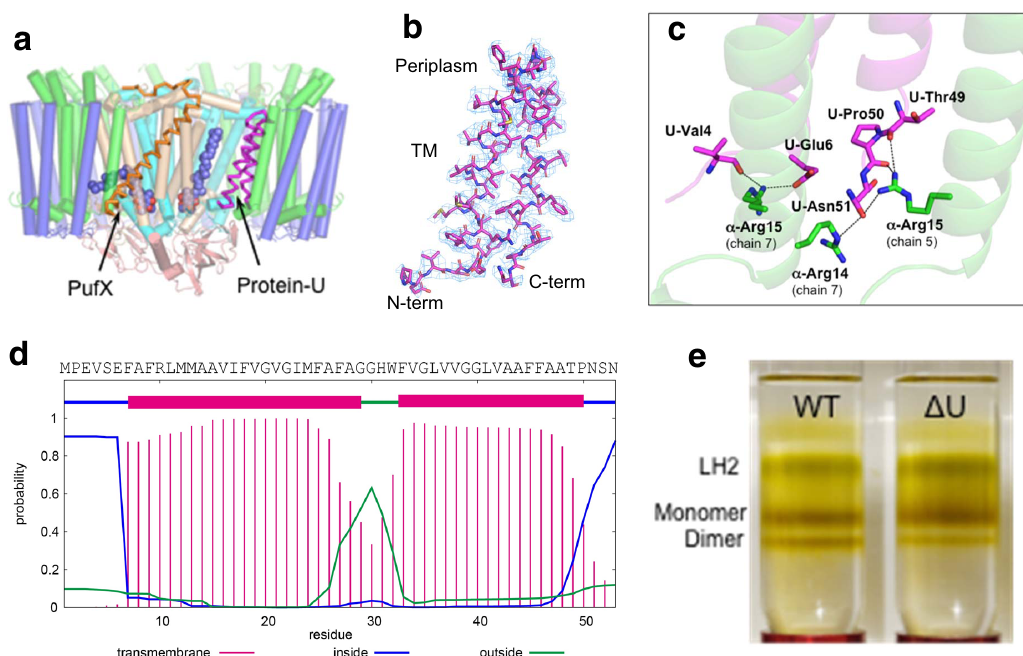
Fig. 2 Structure and property of Rba. sphaeroides protein-U. a Relative position of protein-U (magenta ribbon) in the LH1-RC. PufX is shown by the orange ribbon and the UQ-10 at Q A and Q B sites are shown by blue spheres. All other proteins are shown by cylinders with the same color scheme as in Fig. 1(a). b Structure of protein-U and its density map at a contour level of 3.0 σ . c Close contacts (<3.5 Å, dashed lines) between the protein-U terminal regions (magenta) and LH1 α -polypeptides (green). d Amino acid sequence of protein-U and its two consecutive transmembrane regions predicted by the